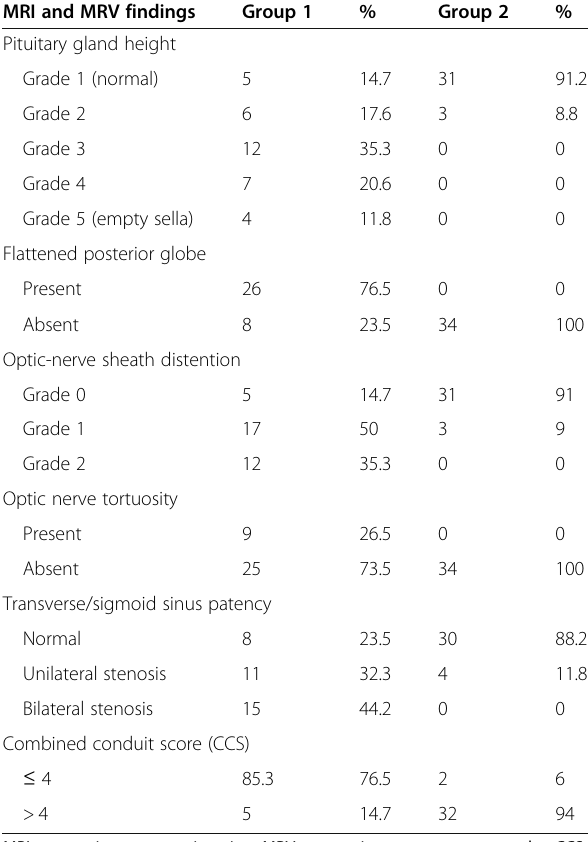
Table 2 Visual abnormalities in studied patients Abnormality